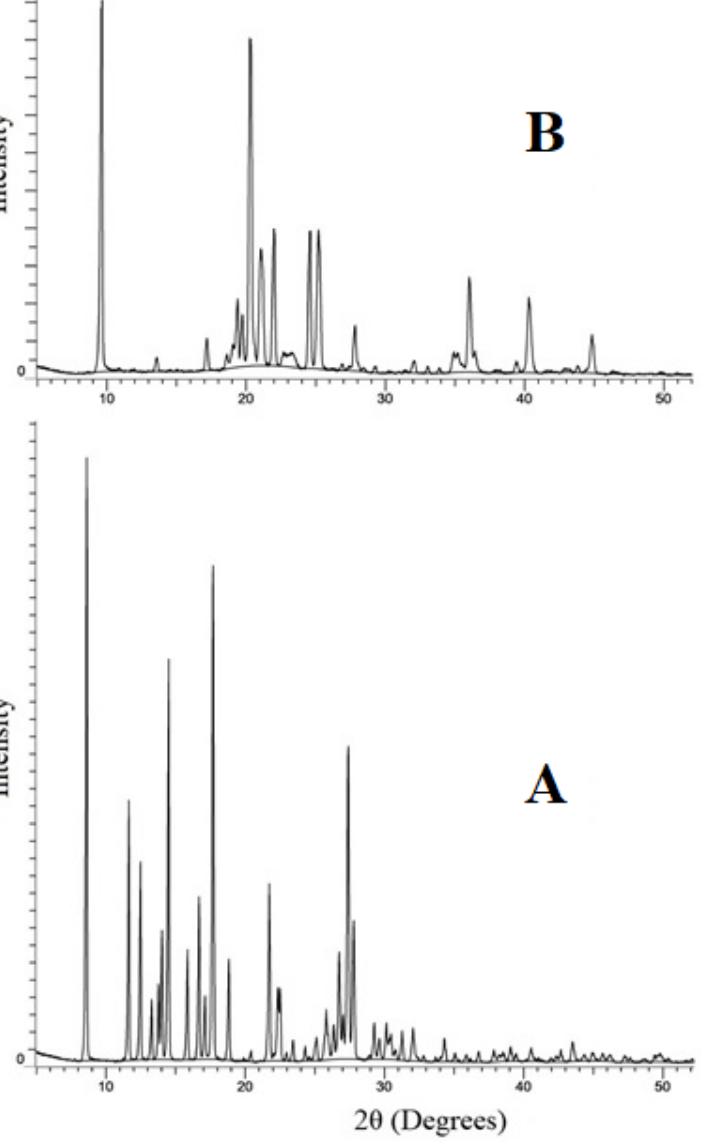
Figure 7. XRPD diffractograms of ( A ) pure drug PRX and ( B ) freeze-dried optimized formulation NS9.